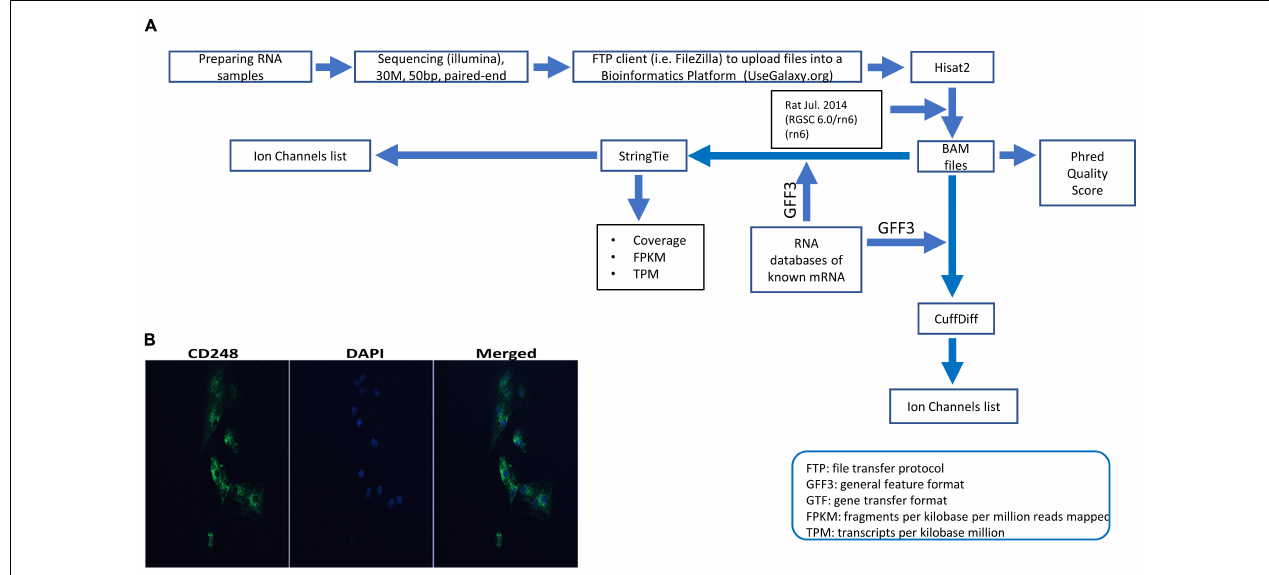
FIGURE 1 | Experimental pipeline and verification. (A) Schematic of the next generation sequencing (NGS) pipeline. RNA was extracted from synovial tissue from eight animals, were split into control and test groups and the test samples were treated with 10 ng IL1 β and TNF α as described in the section “Materials and Methods.” These eight samples sequenced with Illumina and raw data files were uploaded using a FTP client to a bioinformatics platform for analysis. Within the bioinformatics platform, reads were aligned/mapped with Hisat2 program using the reference genome Rat Jul. 2014 (RGSC 6.0/rn6) (rn6). The resulting BAM files were used to measure phred quality score for all samples. Also, BAM files along with an annotation file (Rat GFF3) to assemble mapped reads and quantify gene expression. Such assembly and quantification took place with StringTie and CuffDiff package/tool that generated gene abundance estimates and differentially expressed genes, respectively. After that, using several servers and a local custom-script in MATLAB software allowed us to filter the transcriptome for all known ion channel genes for further analysis (for example, see Tables 1 , 2 ). (B) Expression of CD248 in FLS cells. Immunofluorescence FLS cells showing the FLS marker CD248. DAPI was used for nuclear counterstaining (see Supplementary Methods in Supplementary File S2 for